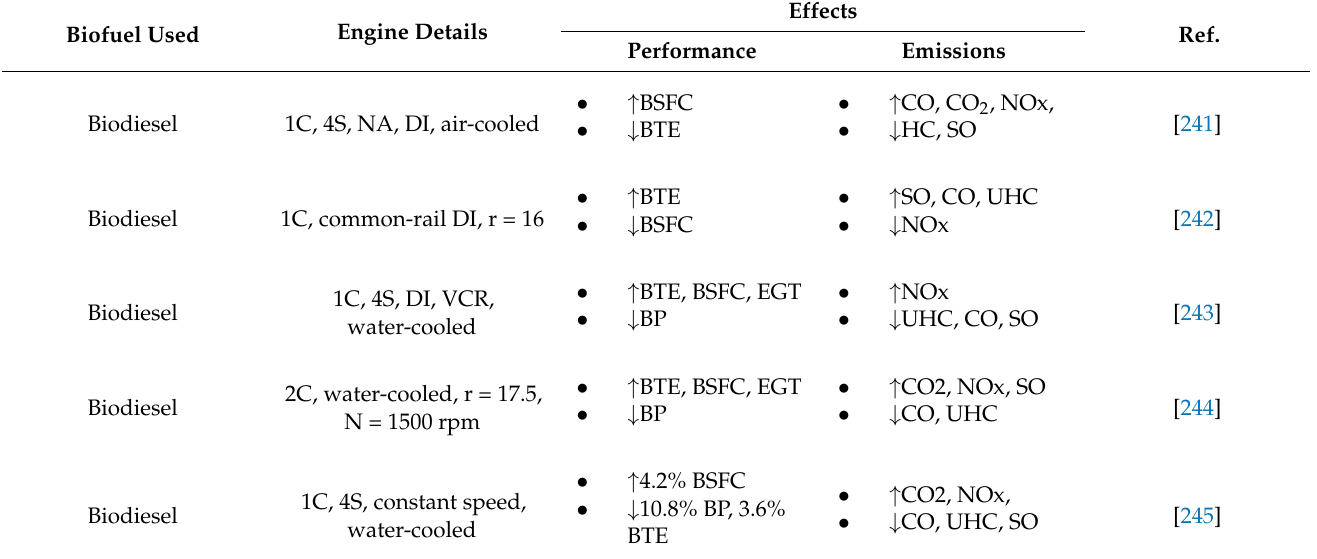
Table 14. Effects of biodiesel, F-T diesel, and DME as alternative fuels for CI engines. Biofuel